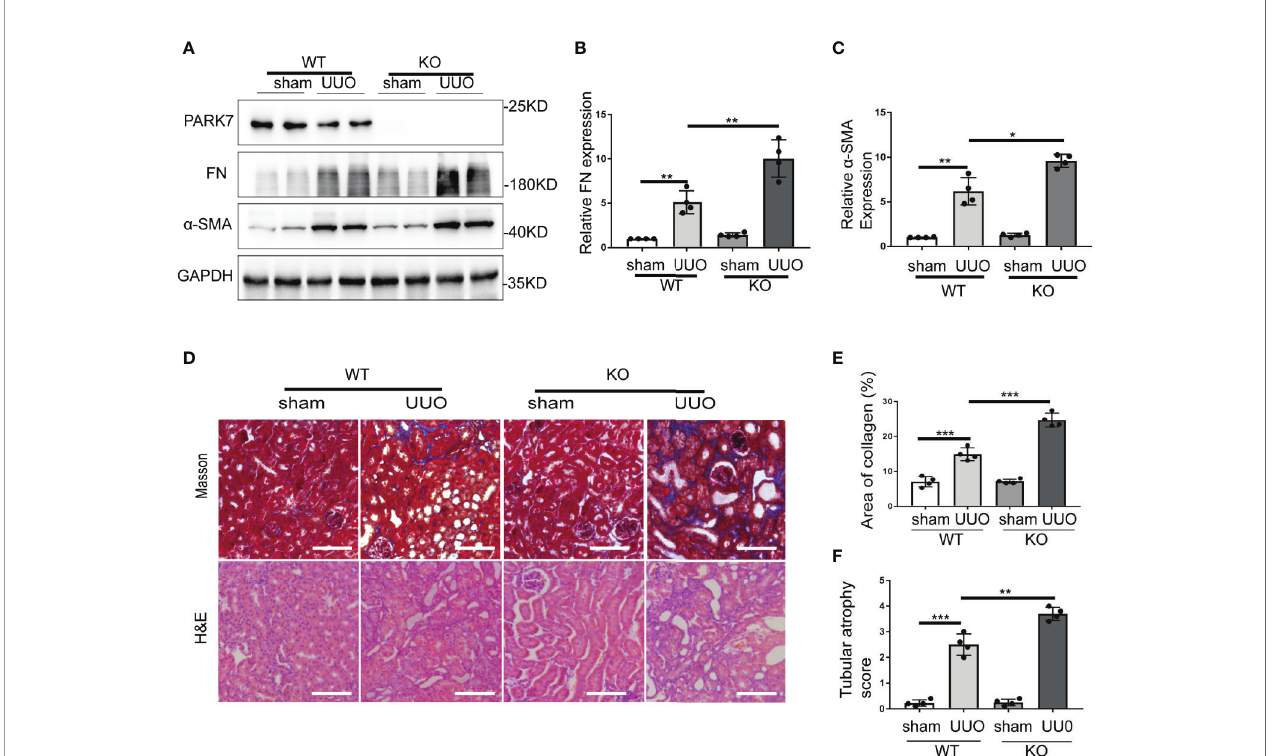
FIGURE 2 | PARK7 de fi ciency aggravates UUO-induced renal interstitial fi brosis. Park7 knockout (KO) and wildtype (WT) mice were subjected to either sham operation or UUO surgery. The mice were euthanized at 7 days and UUO-obstructed kidneys were collected. (A) Representative blots of PARK7, Fibronectin (FN), a -SMA and GAPDH(as a loading control). (B, C) Densitometry of FN and a -SMA signals(n=4). The signal of FN, a -SMA was normalized to the GAPDH signal of the same samples to determine the ratios. The values are expressed as fold change over sham control in WT mice. (D) Representative images of Masson ’ s trichrome staining and hematoxylin and eosin (H&E) staining. Bar: 100 m m. (E) Quantitative analysis of Masson ’ s trichrome staining. (F) Tubular atrophy score(n=4). Tubular atrophy was graded by 0, 1 (1% ‐ 25%), 2 (26% ‐ 50%), 3 (51% ‐ 75%), 4 (76% ‐ 100% tubules showing atrophy. Each symbol (circle) represents an individual mouse. Error bars: SEM. *p < 0.05, **p < 0.01, ***p <